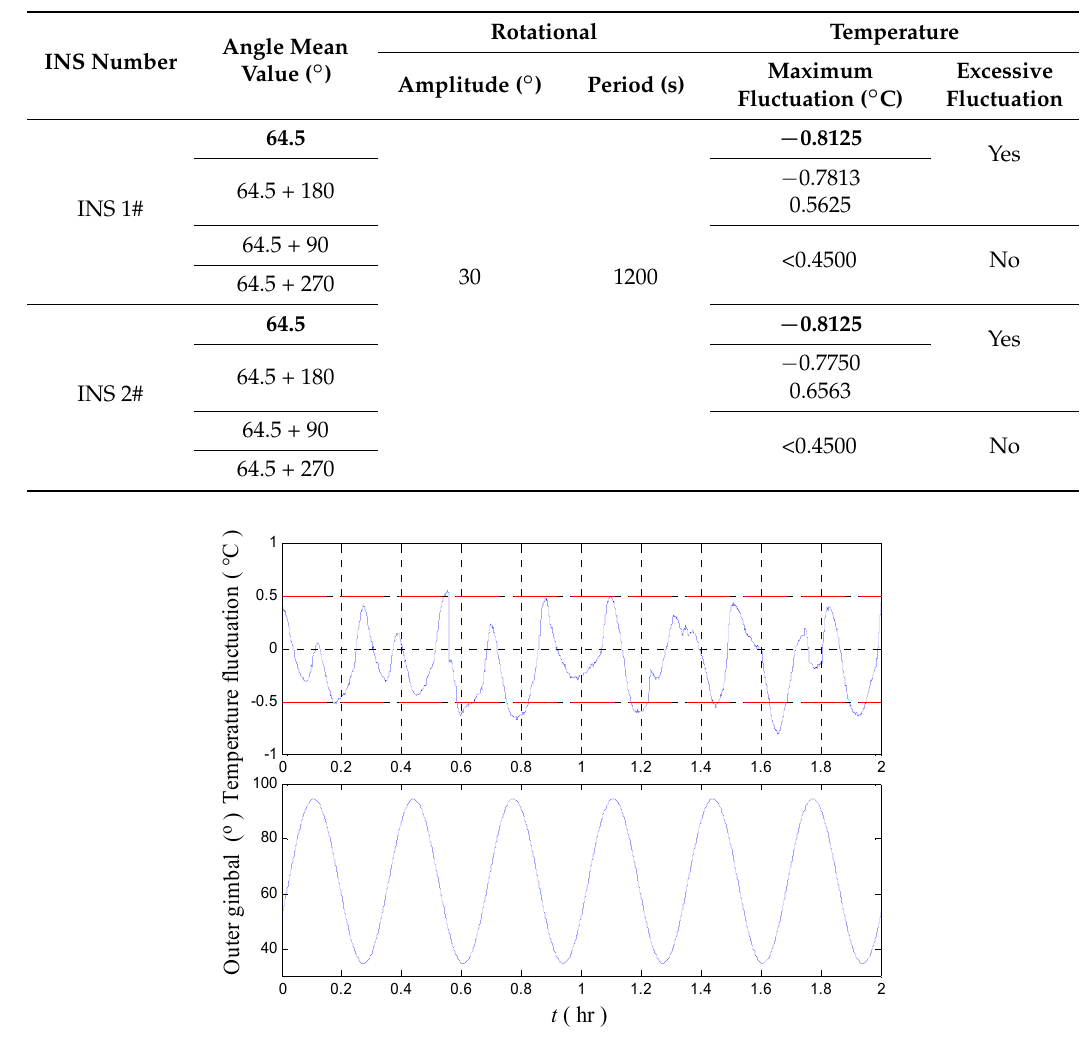
Table 2. Sinusoidal periodic rotation process and relevant parameters of the outer gimbal.